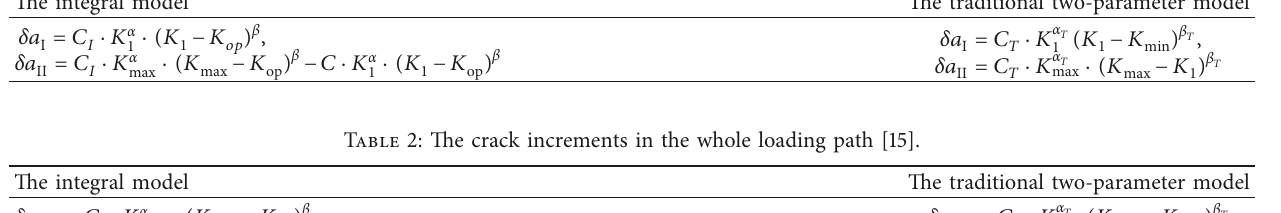
Table 1: The crack increments in the two stages of loading path. The integral model The traditional two-parameter model